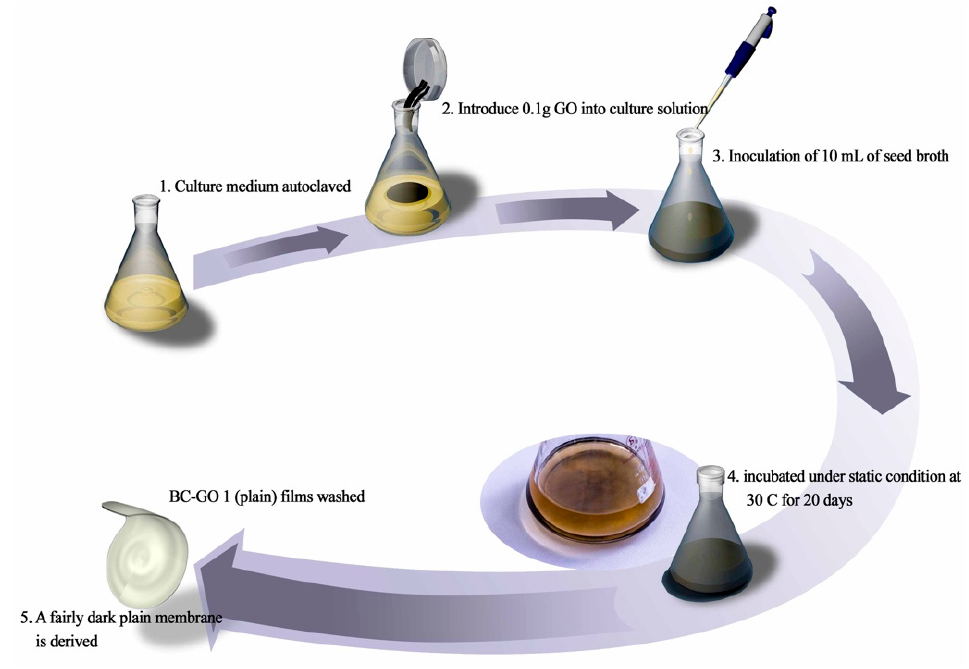
Scheme 1. Synthesis of BC/GO 1.